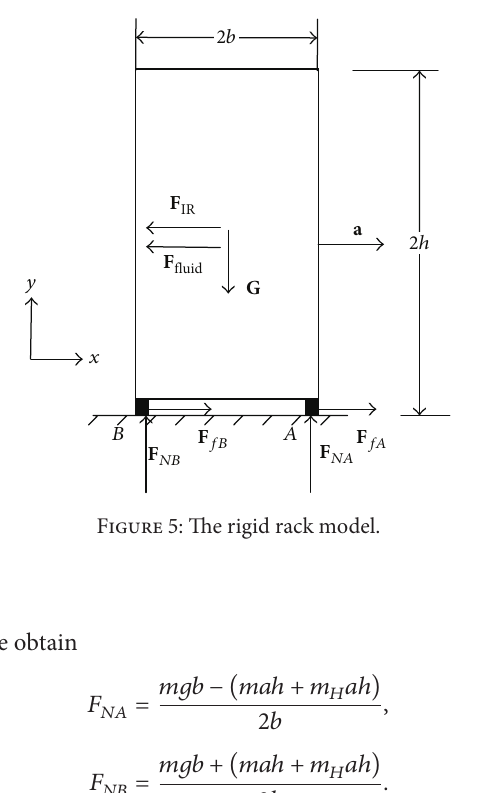
Figure 5: The rigid rack